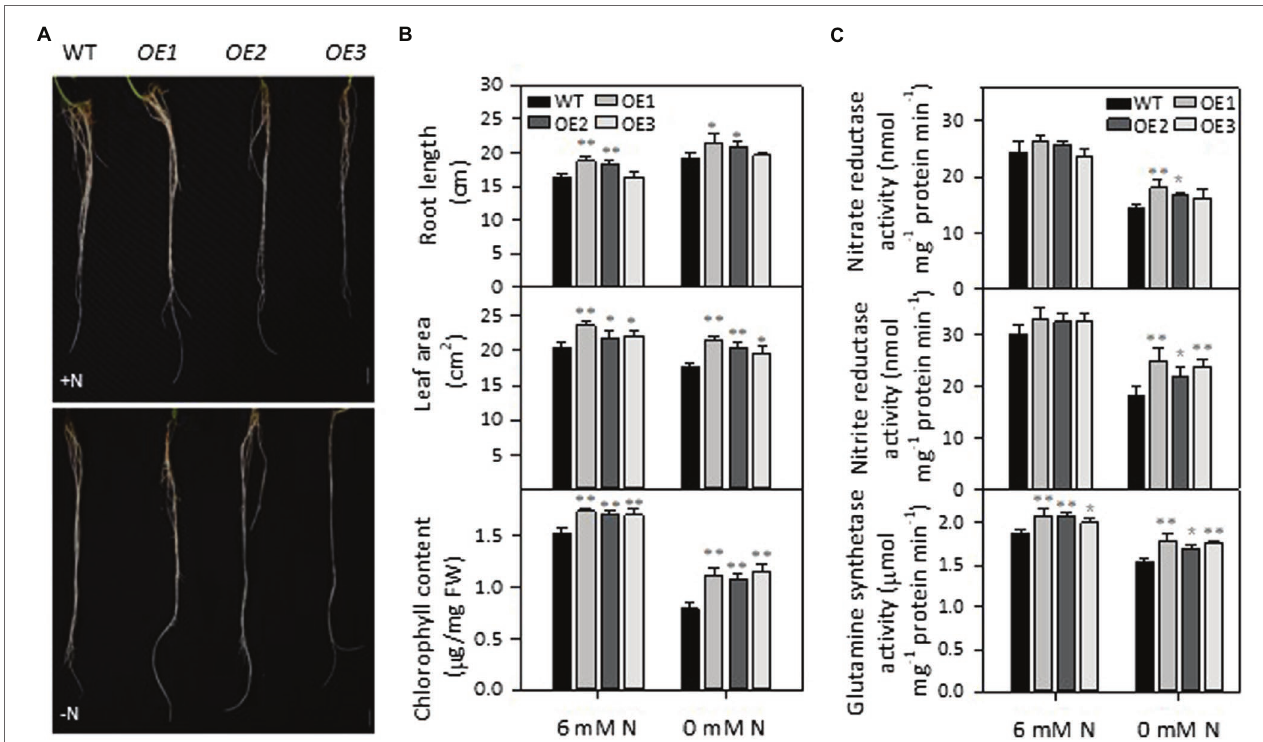
FIGURE 2 | Phenotype of AtPLD ε -overexpressing soybean plants. (A) Root morphology of WT and AtPLD ε OE soybean plants under nitrogen-sufficient and -deficient conditions. Two-week-old soybeans grown on nitrogen rich liquid medium were transferred to nitrogen rich (6 mM N) or free (0 mM) liquid medium for 7 days. Scale bar = 1 cm. (B) Root length, leaf area, and chlorophyll content of WT and AtPLD ε OE soybean plants under nitrogen-sufficient and -deficient conditions. The values are means ± SD ( n = 3, r = 5). *Denotes statistical significance at p < 0.05 and **denotes statistical significance at p < 0.001 compared with WT as determined by one-way ANOVA (Duncan’s multiple range test). (C) Activity of nitrate reductase, nitrite reductase, and glutamine synthetase (normalized to equal amounts of protein) in the leaves of WT, and AtPLD ε OE soybean. The values are means ± SD ( n = 3, r = 5). *Denotes statistical significance at p < 0.05 and **denotes statistical significance at p < 0.001 compared with WT as determined by one-way ANOVA (Duncan’s multiple range